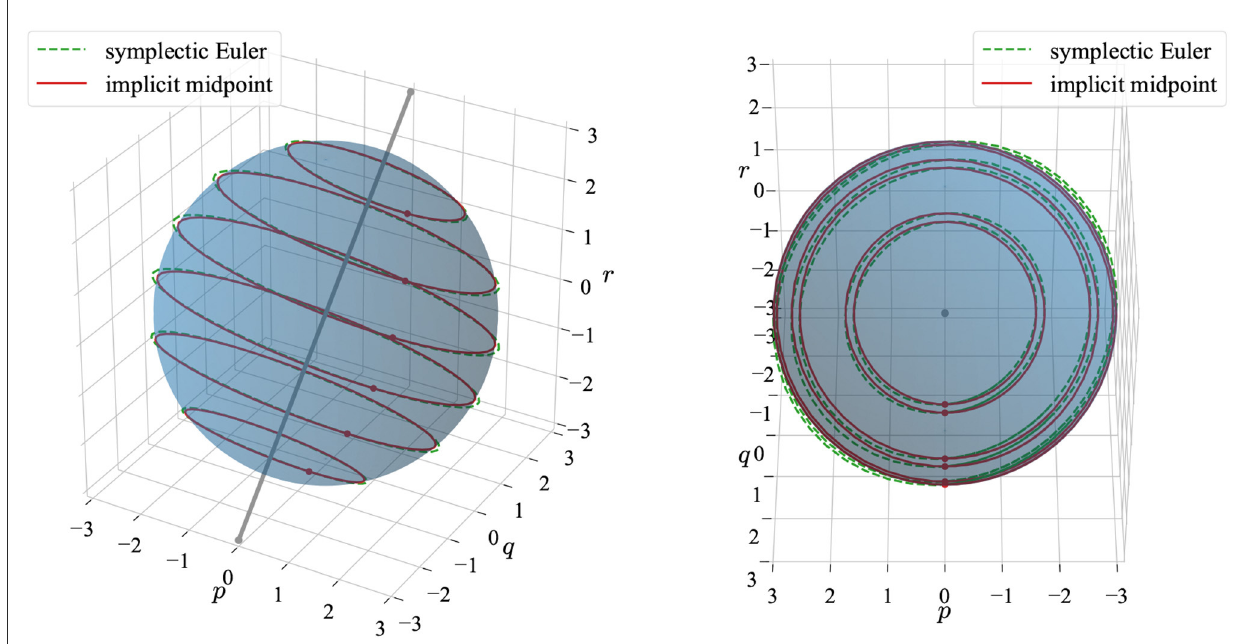
FIGURE2 Two views of the approximate orbits of the Poisson system in Example 2 on the phase-space ( p , q , r ). The approximate orbits lie on planes with normal vector (0,1,1) so that q + r is a constant. The orbits in the dashed-green line were computed using the symplectic Euler method are ellipses and the ones in solid-red were computed using the implicit midpoint method and are circles. The blue sphere represents the constant Hamiltonian value corresponding to H = 3 2 /